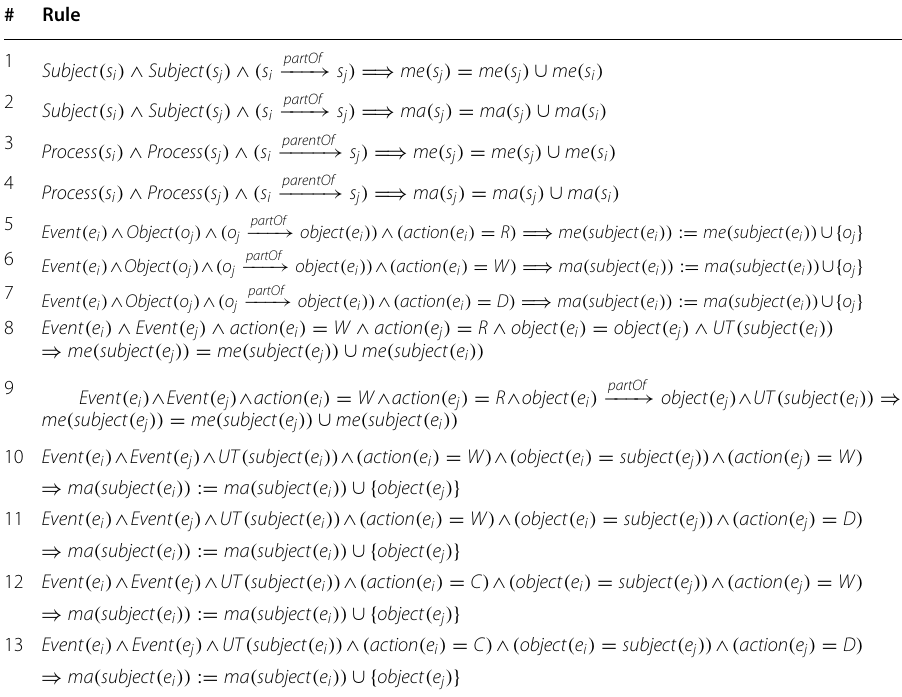
Table 3 Patterns of transition rules [16]